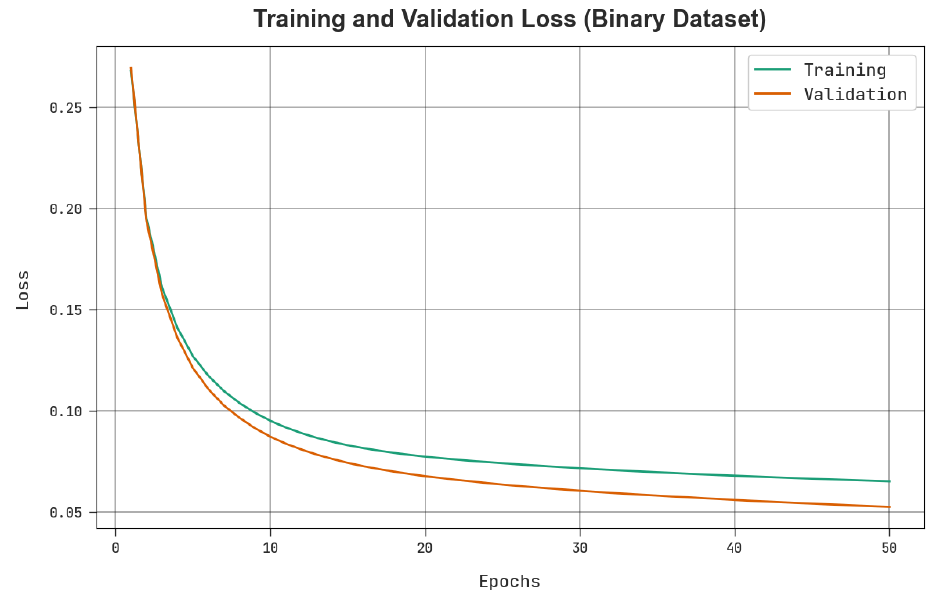
Figure 6. Loss curve of the H3SC-DLIDS approach on a binary dataset. Table 4. Classification results of the proposed H3SC-DLIDS approach on the multiclass